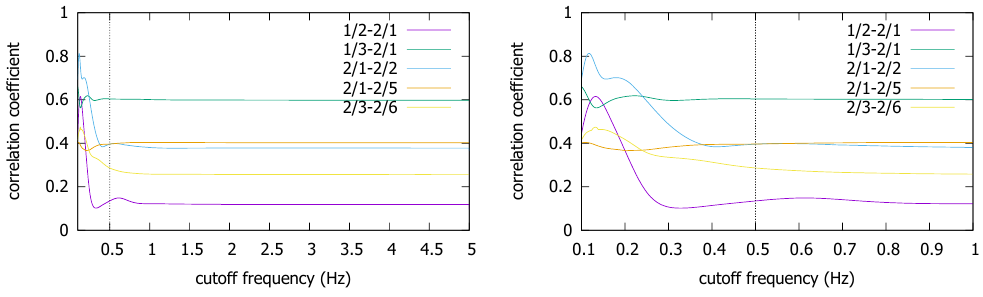
Figure 14. ρ max for non-coexistent trace pairs from the Pisa dataset.